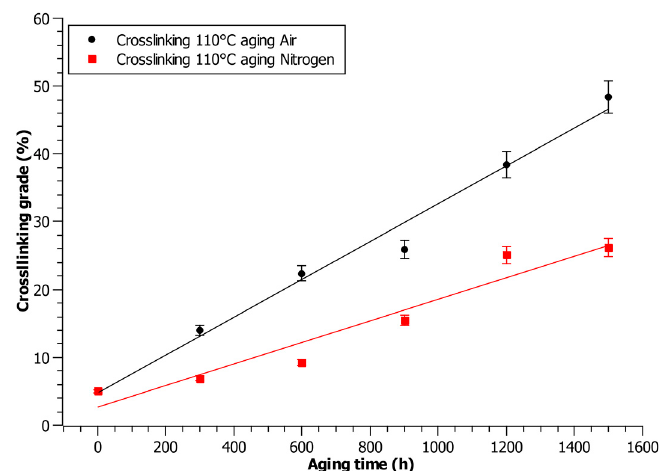
Figure 5. Crosslinking grade as a function of the aging time: ( black ) in air; ( red ) in nitrogen 110 °C aging.